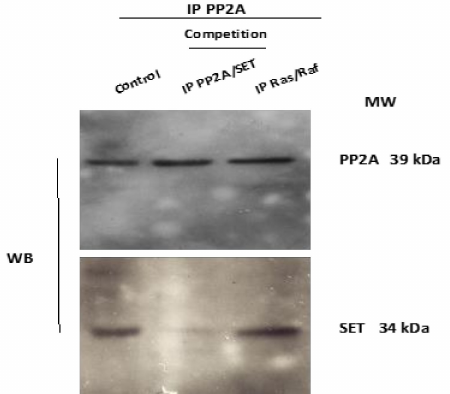
Figure 1. The IP disrupted PP2A/SET interaction in vitro. Lysates were immunoprecipitated with anti PP2A antibody. The PP2A/SET interaction was competed in vitro with 1 mM of the PP2A/SET IP and with an irrelevant Ras/Raf IP used as a negative control. The total amount of PP2A was used as internal